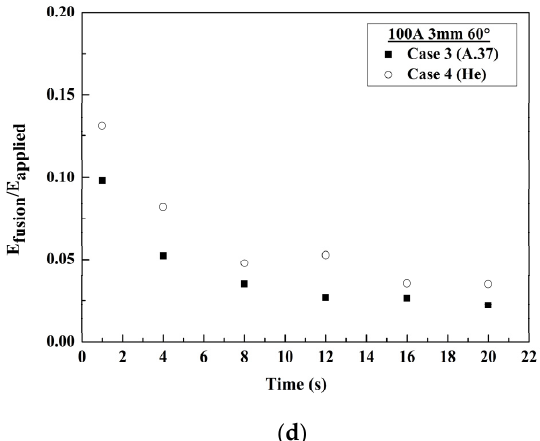
Figure 5. ( a ) Effect of the shielding gas on the evolution of the weld pool width; ( b ) Effect of the shielding gas on the evolution of the weld pool shapes; ( c ) Effect of the shielding gas on the depth ‐ to ‐ width ratio; ( d ) Effect of the shielding gas on the ratio between the energy used to fuse the metal and the energy applied to the system.